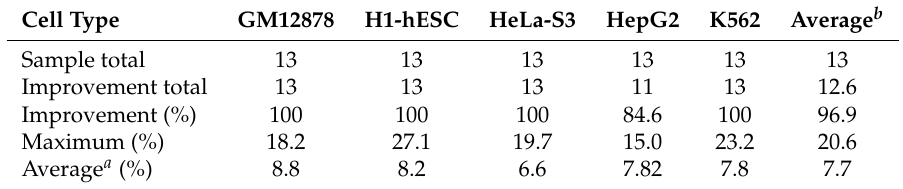
Table 3. Details of the comparison between cross-cell-type prediction by DANN_TF and supervised prediction by the baseline method. (Average a denotes the average improvement, Average b denotes the micro average over the total number of samples).